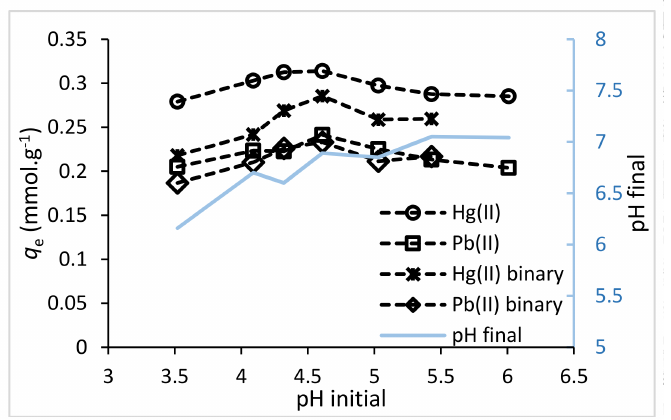
Figure 3. Adsorption capacity at different pHs. ( T : 20 ◦ C; sorbent dosage: 1 g · L − 1 ; agitation